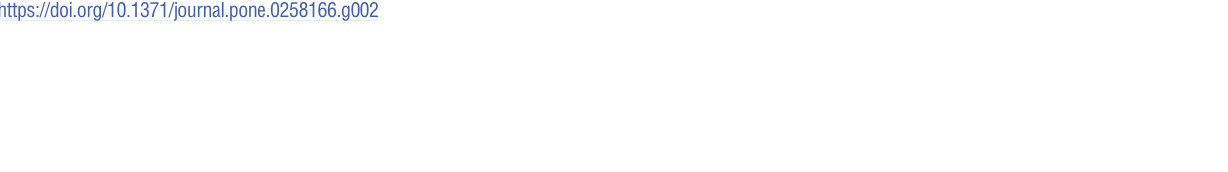
PLOS ONE | https://doi.org/10.1371/journal.pone.0258166 October 4, 2021 8 /